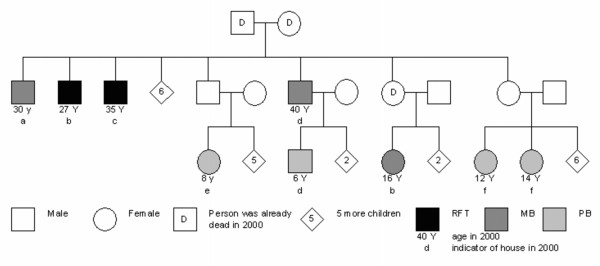
Part of the extended pedigree of family one, showing family relations between leprosy patients.